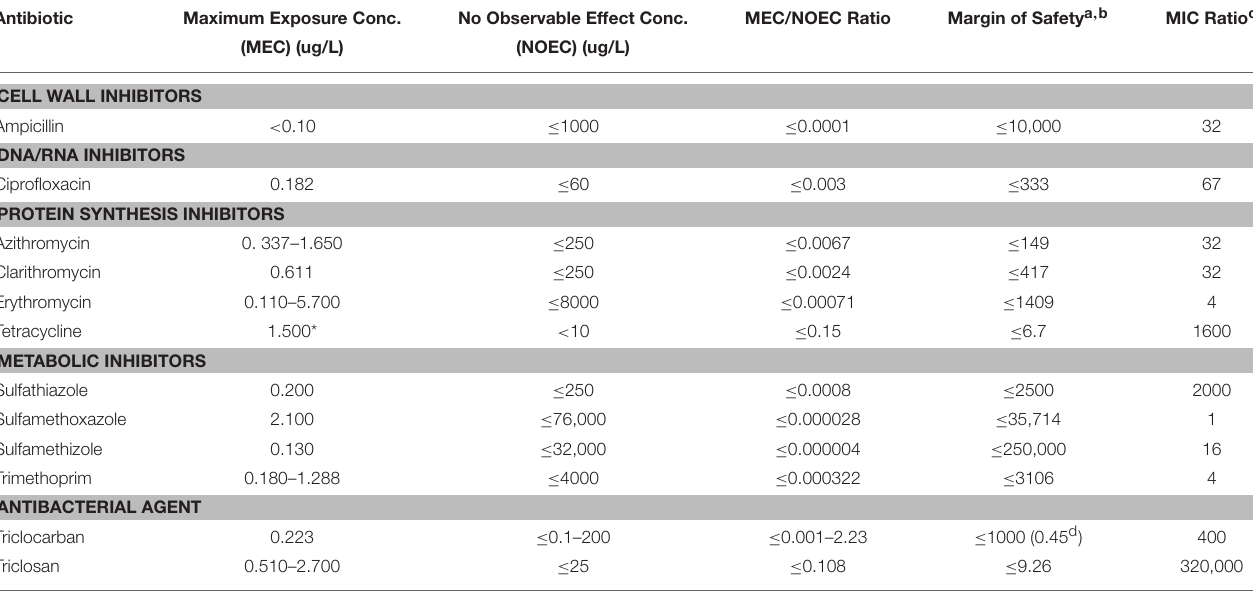
TABLE 7 | The Maximum Exposure Concentration (MEC), NOEC, MEC, NOEC Ratio, Margin of Safety, and MIC Ratio for 10 commonly detected antibiotics and two antibacterial agents. Antibiotic Maximum Exposure